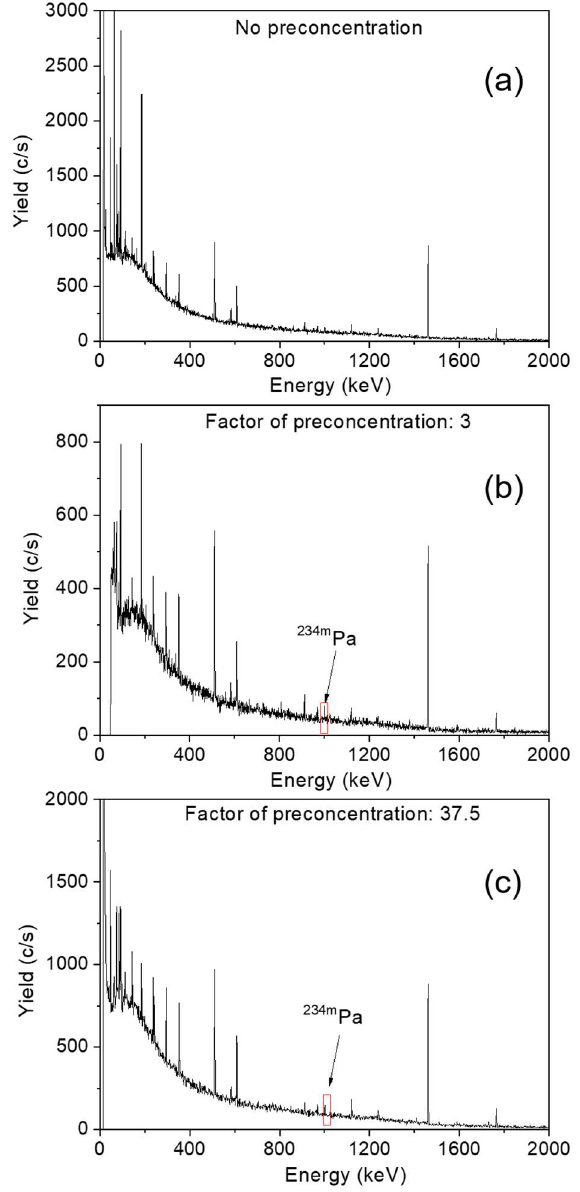
Figure 3. The HPGe gamma spectra acquired, for the investigated drinking water sample, with no preconcentration ( a ), factor of preconcentration equal to 3 ( b ) and 37.5 ( c ).